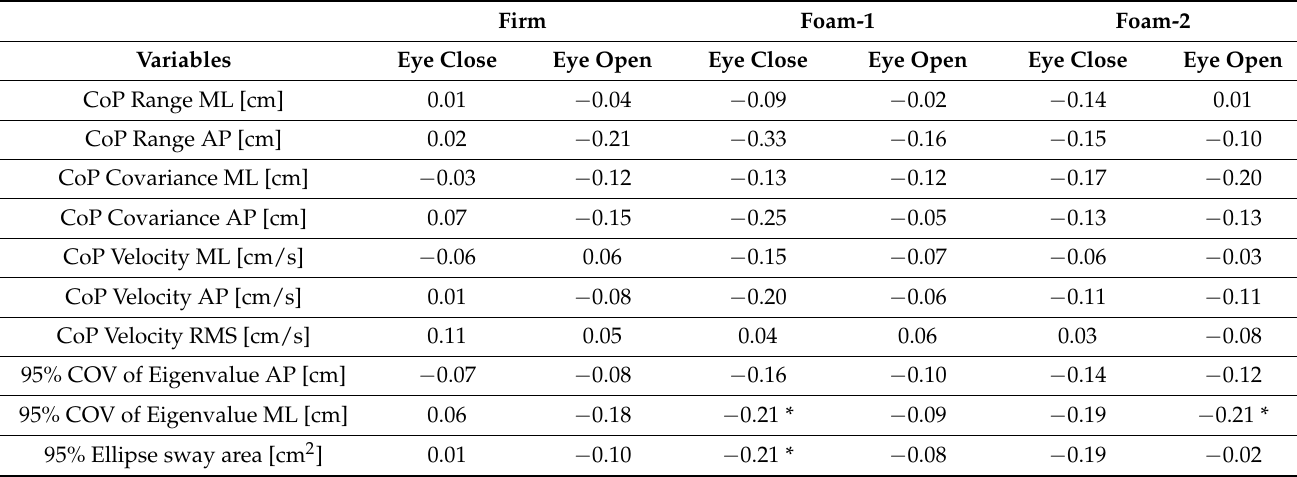
Table 5. Correlation between BBS score and each condition